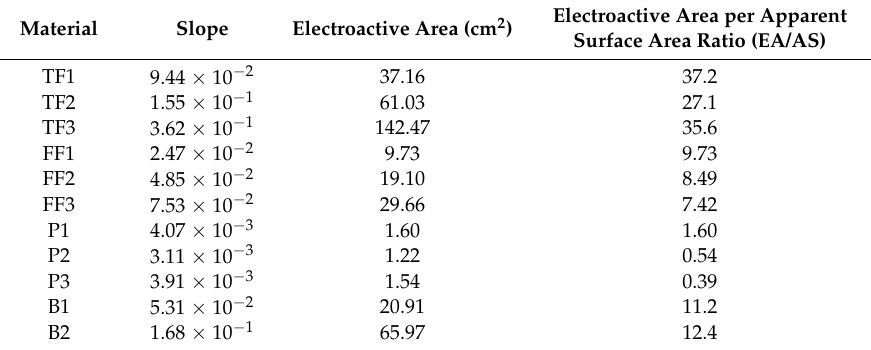
Table 3. Electroactive areas.